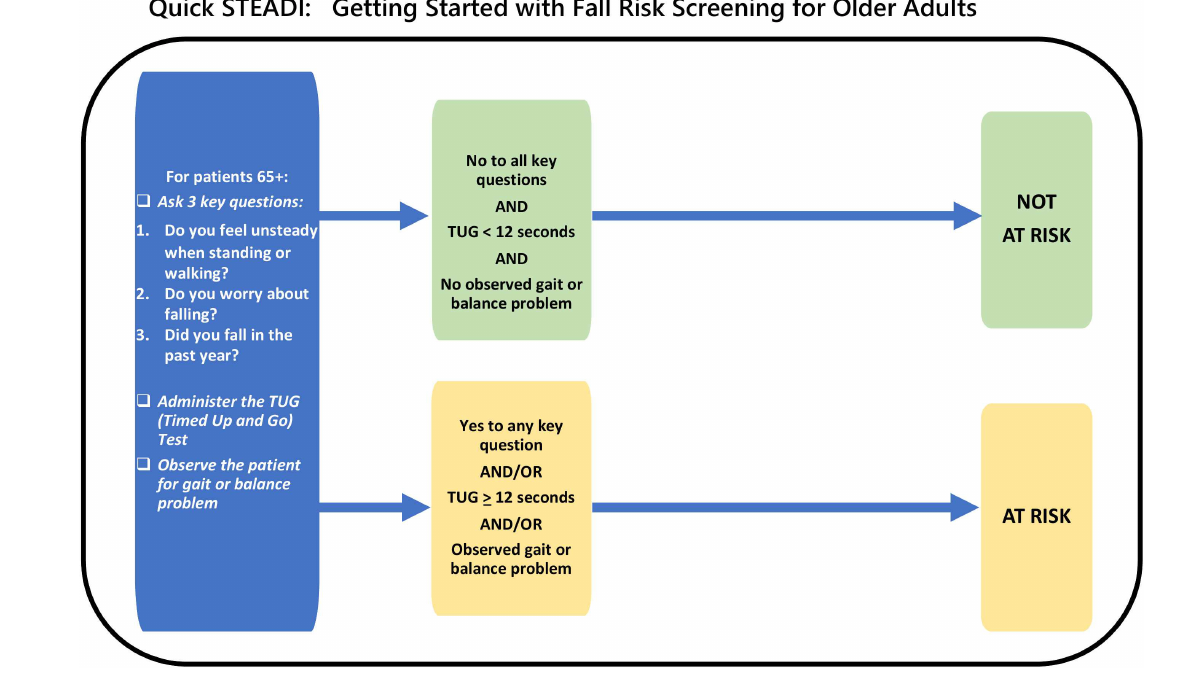
FIGURE 2 | Adapted two-level Quick-STEADI algorithm